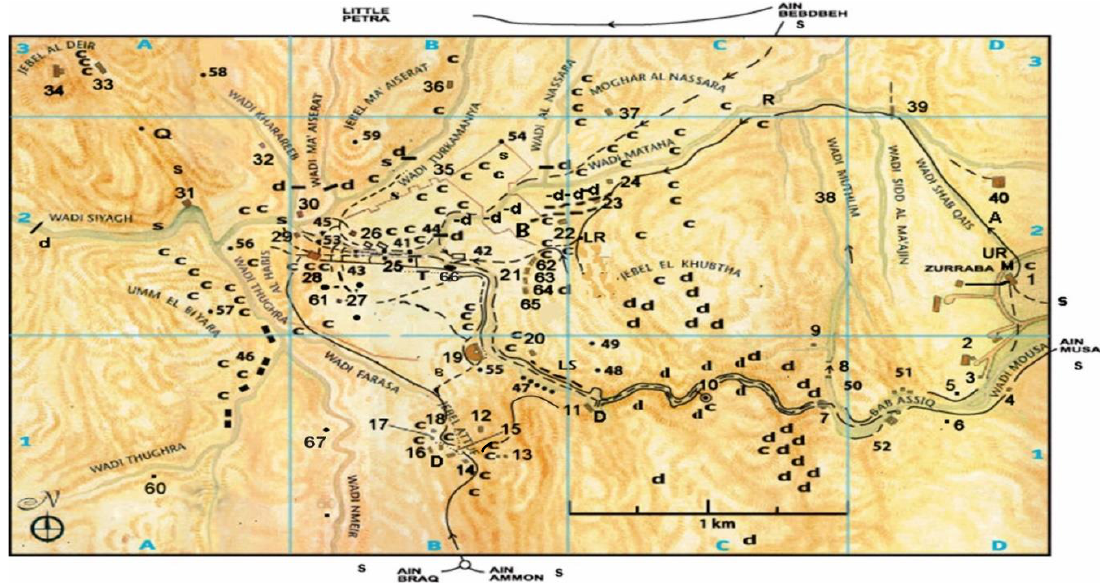
Figure 1. Petra with numbered site names given in Appendix A.1. Figure from [2], p. 266.